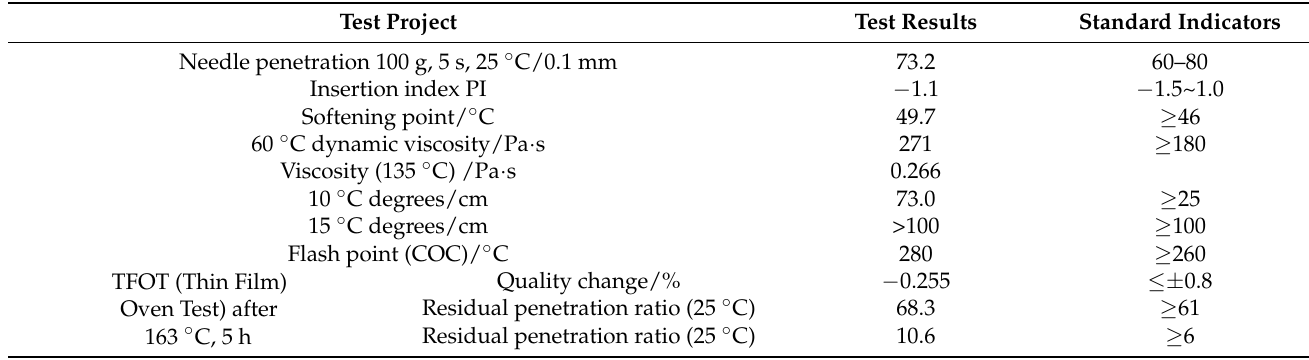
Table 1. Performance index of 70# base